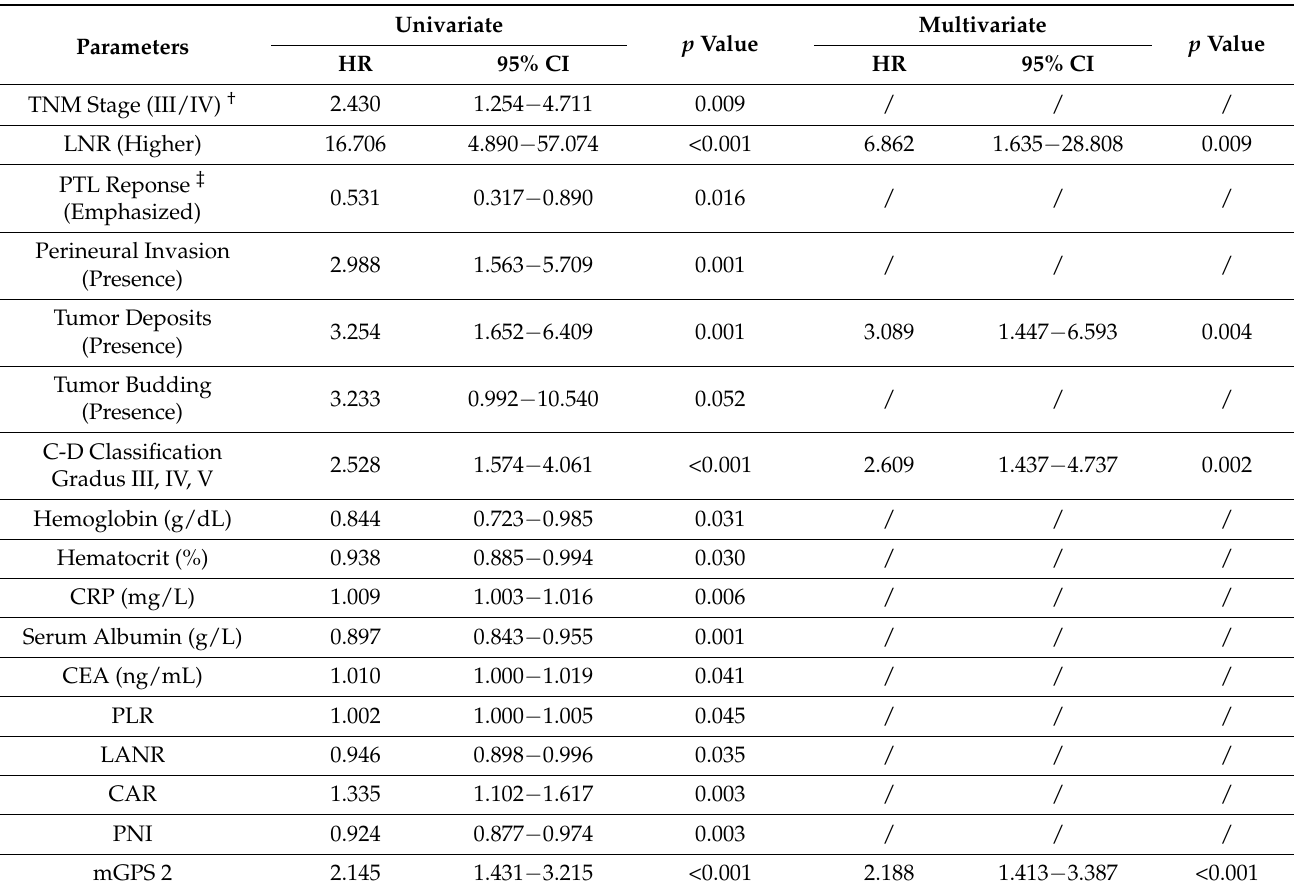
Table 3. Univariate and multivariate Cox regression analysis of overall survival in patients with colorectal